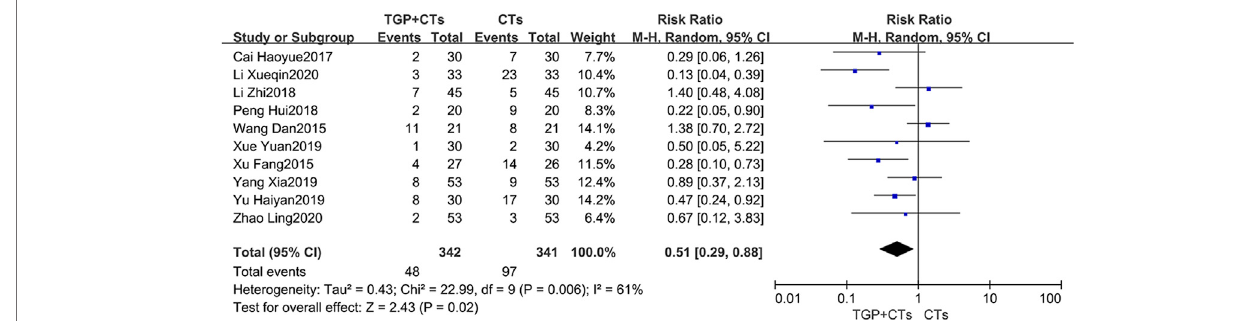
FIGURE 11 | Forest plot of incidence of adverse reactions.